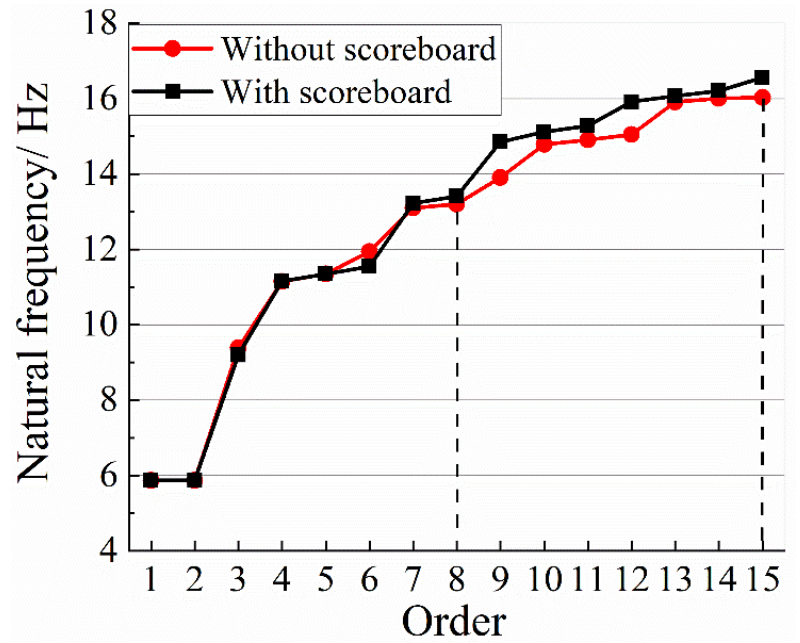
Figure 10. First 15-order natural frequencies of the two overall models.